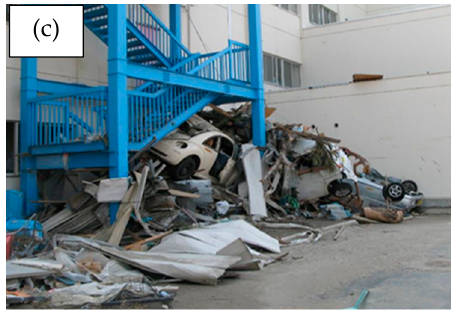
Figure 3. Damage from cars: ( a ) a dump truck collided against a warehouse at the Kirinda fishing port in Sri Lanka, ( b ) a passenger car collided against a shop at Miyako in Japan, and ( c ) many cars were pushed against the corner of a school building at Sendai in Japan.